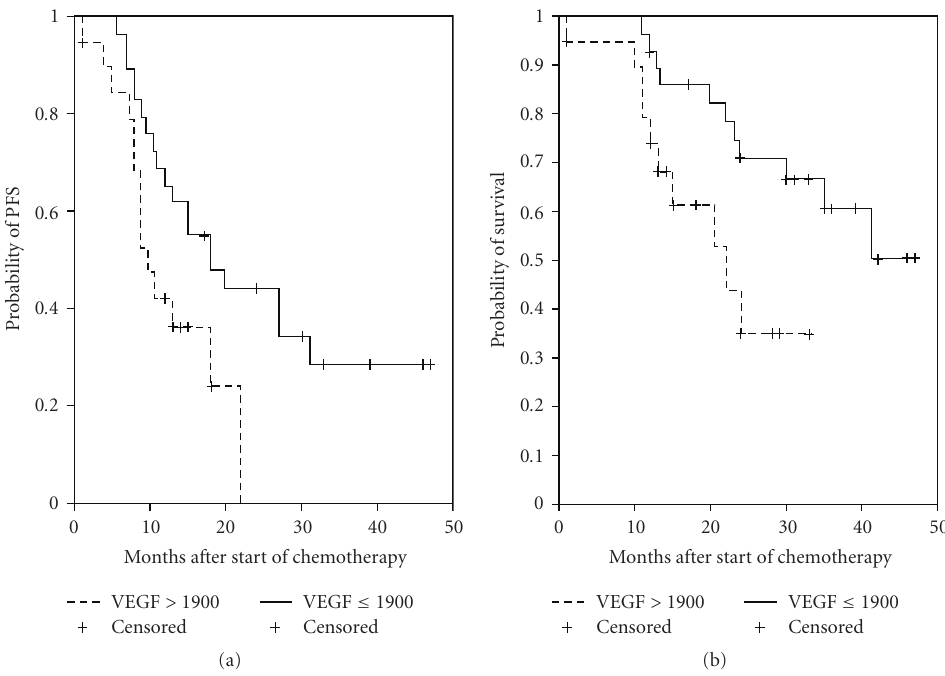
Figure 3: Clinical data concerning patients undertaking chemotherapy. Progression-free survival (a) and overall survival (b) of 54 patients with advanced ovarian cancer receiving first-line, platinum-based chemotherapy, according to VEGF levels in ascites. The lower levels were associated with significantly longer progression-free ( P = . 0297) and overall ( P = . 0164). Median followup: 33